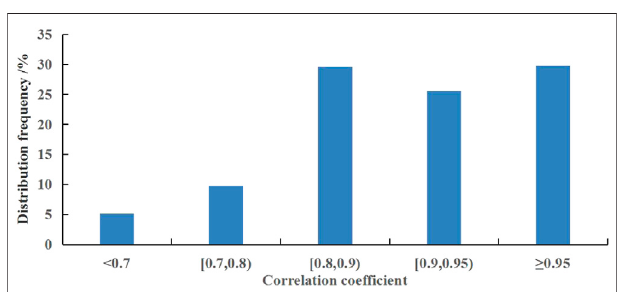
FIGURE 6 | Frequency distribution of correlation coef fi cients for the cross-validation of precipitation anomaly percentage.